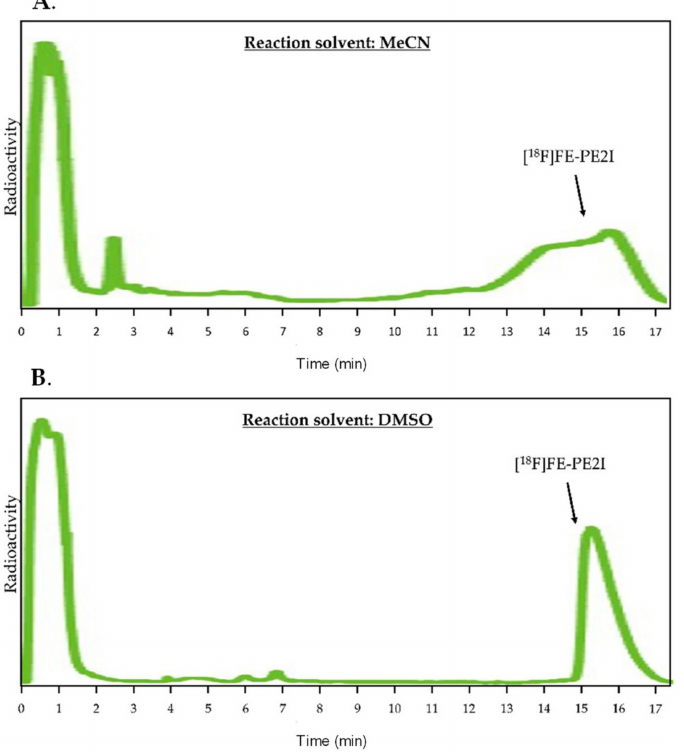
Figure 7. ( A ) Preparative HPLC chromatogram from the improved elution method with MeCN as the reaction solvent. ( B ) Preparative HPLC chromatogram from the improved elution method with DMSO as the reaction solvent. Both chromatograms were extracted from the synthesis reports with the time axis added for clarity. The full synthesis reports can be found in the Supplementary Materials.